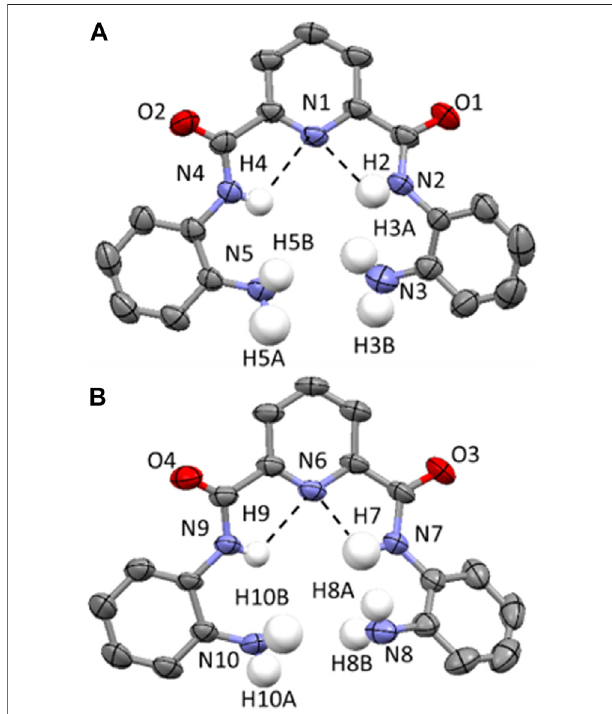
FIGURE 4 | (A and B) Molecular structure of two distinct molecules of compound 3 found in the unit cell. Displacement ellipsoids are at 50% probability level. Hatoms areshown in white, Cin grey,N inlightblue and C in red.AllHatoms(exceptforthoseontheNatomsoftheamideandamine functionalities) have been removed for clarity. Hydrogen-bonding interactions are shown as dashed black